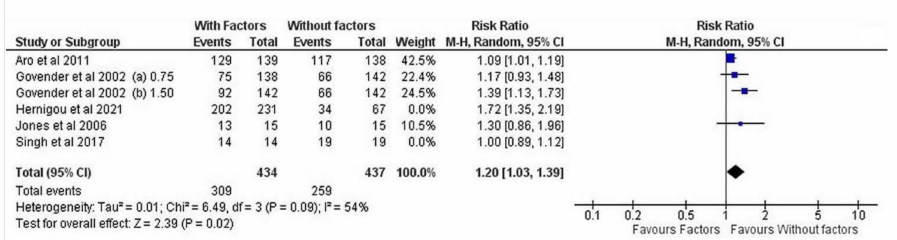
Figure 7A. On the contrary, the application of autologous MSCs in open tibial fractures (with gaps less than 10 mm) Gustilo–Anderson Type II or III as well as in closed non-united long bone fractures was correlated with a mild increase (I 2 = 72%, 95% CI = 0.31 [0.05–1.92], Z = 1.26, p = 0.21) of the risk for persistent non-unions and re-fractures, as shown in Figure 7B.